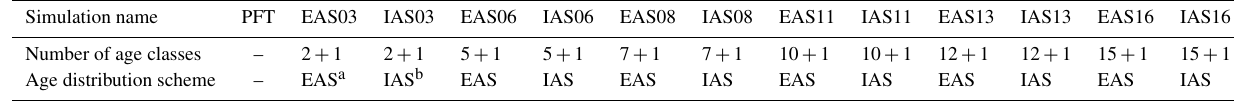
Table 1. Conducted simulations with number of age classes and applied age distribution scheme. The “ + 1” in the number of age classes refers to the youngest age class, which always covers the years 0 to 1 in